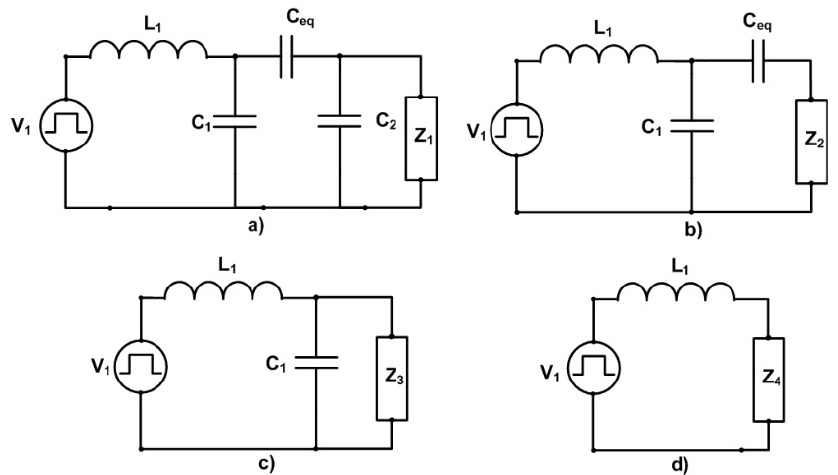
Figure 6. Modified Z circuit reduction process: ( a ) Equivalent Z-Tank modified; ( b ) Z 1 and C 2 in parallel are reduced to Z 2 ; ( c ) C eq and Z 2 in series are reduced to Z 3 ; ( d ) C 1 and Z 3 in parallel are reduced to Z 4